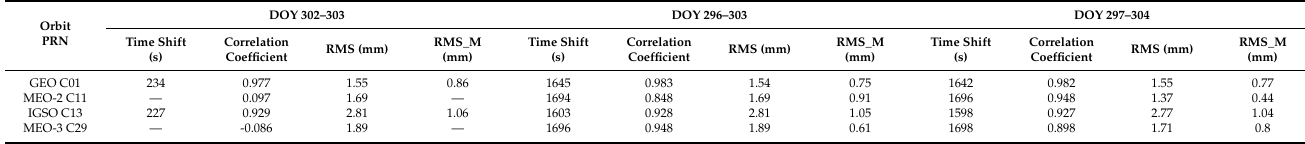
Table 1. The statistics of multipath mitigation for C01/C11/C13/C29.